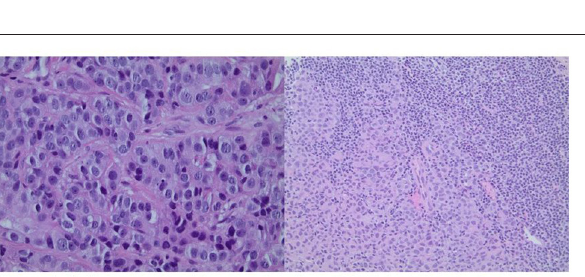
recommended anastrozole and outpatient follow-up